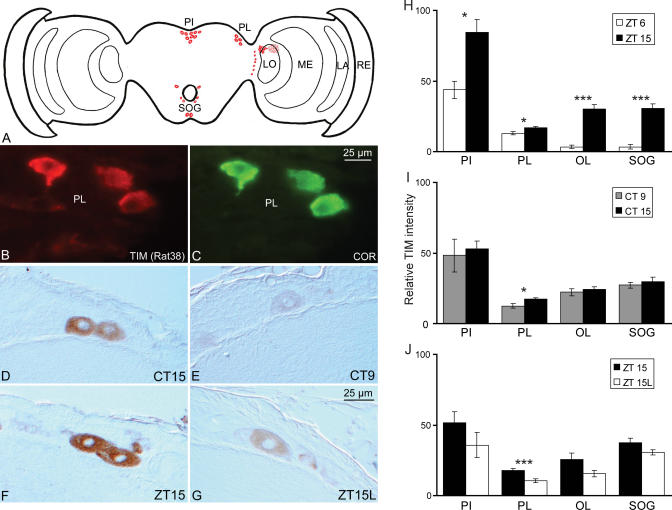
Distribution and Regulation of TIM Immunoreactivity in Monarch Brain(A) Schematic representation of a frontal section illustrating the topology of TIM-immunoreactive cells using antibody TIM-R38. Although an identical pattern of TIM staining was obtained with TIM-GP47, TIM-R38 was used in experiments depicted in (B–J), because of stronger signal intensity. RE, retina; LA, lamina; ME, medulla; LO, lobula of optic lobe (OL); PL, pars lateralis; PI pars intercerebralis; SOG, suboesphageal ganglion.(B and C) Double-labeling immunofluorscence of TIM (B) and corazonin (COR; C) in cells in the PL. The three cells shown are co-localized with TIM and COR; the fourth cell was out of the plane of section.(D and E) TIM staining in PL at CT 15 (D) and CT 9 (E). Two cells are shown; the other two were out of the plane of section.(F and G) TIM staining in PL at ZT 15 in darkness (F) or after a 1-h light pulse (ZT 15L) (G). Two cells are shown; the other two were out of the plane of section.(H) Semiquantitative assessment of TIM staining in PI, PL, OL, and SOG at ZT 6 and ZT 15. Intensity values were corrected for relative cell number in each group so that the values could be compared across groups. Each value is mean ± SEM of four animals. *p < 0.05; ***p < 0.001.(I) Semiquantitative assessment of TIM staining in PI, PL, OL, and SOG at the two circadian times (CT 9 and CT 15). Each value is mean ± SEM of eight animals. *p < 0.05.(J) Semiquantitative assessment of TIM staining in PI, PL, OL, and SOG before and after the light pulse (ZT 15 and ZT 15L, respectively). Each value is mean ± SEM of eight animals. ***p < 0.001.